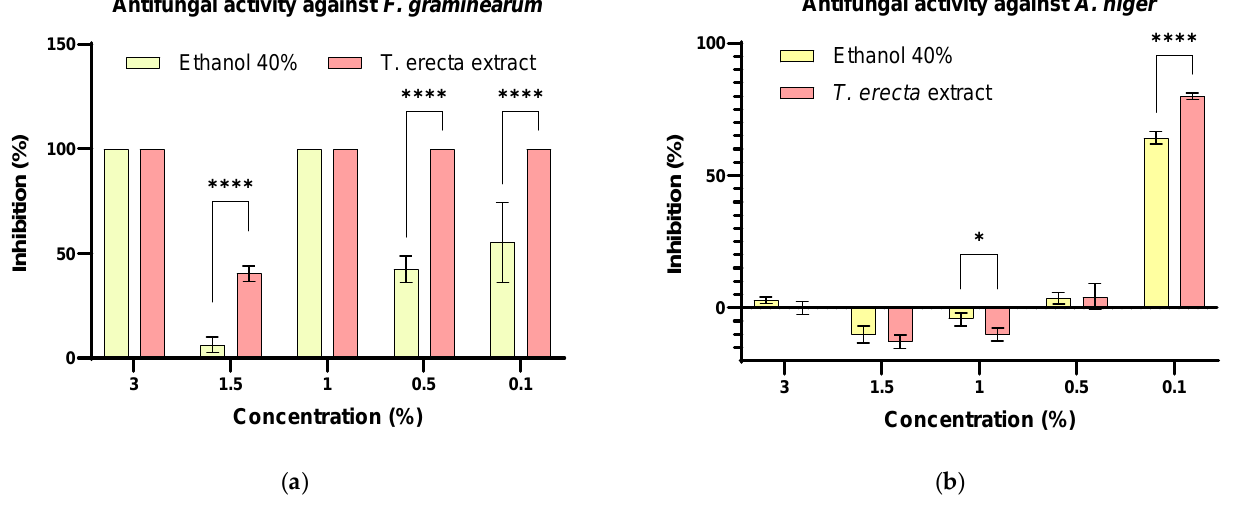
Figure 6. Evaluation of the antifungal effect by inhibiting mycelium growth (%) on PDA medium related to the positive control (untreated strain), both for the extract and solvent used at similar concentrations (* p < 0.05, **** p < 0.0001) on ( a ) F. graminearum and ( b ) A. niger strains.